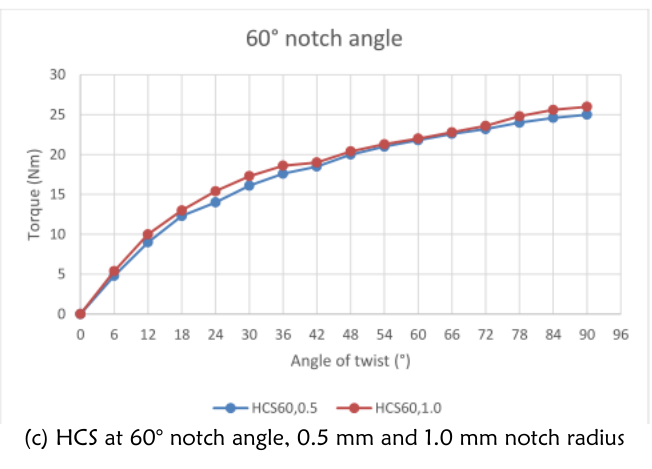
Figure 5: Effect of notch parameters on AISI 1065 steel